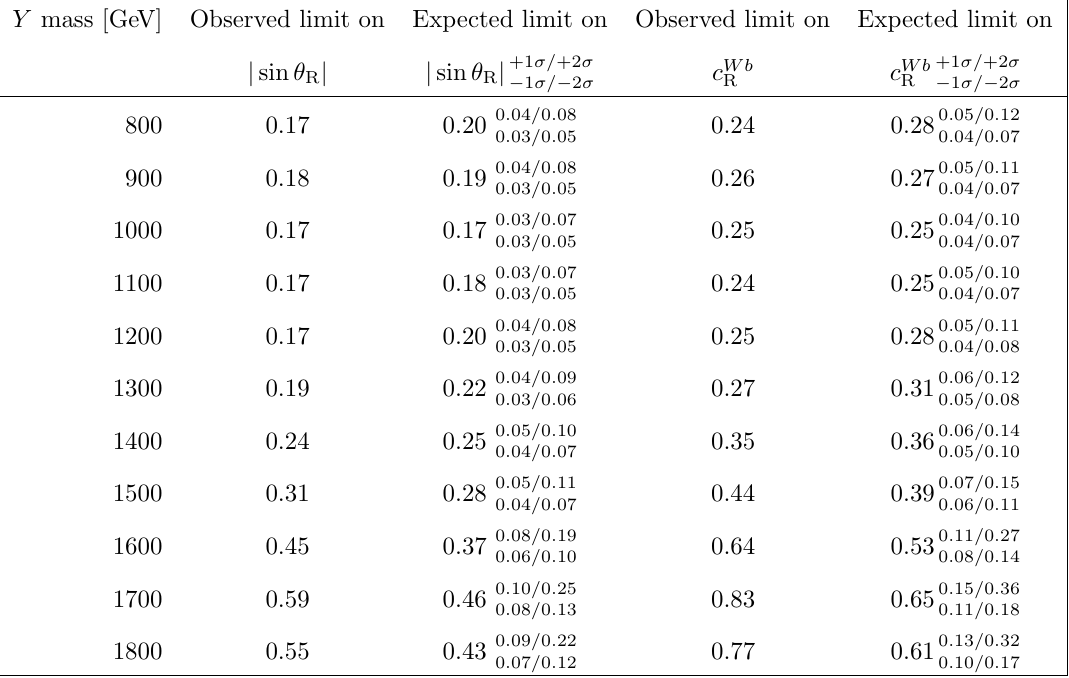
Table 6. Observed and expected 95% CL upper limits on Y quark in a ( B; Y ) doublet model with masses of 800 GeV to 1800 GeV. The uncertainties in the expected limits are also